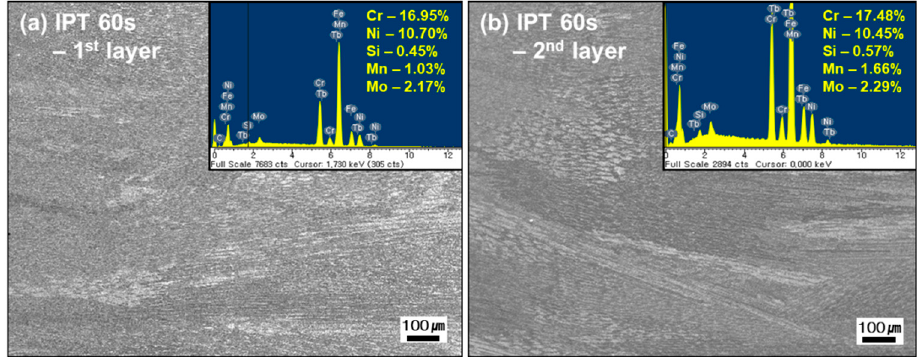
Figure 5. SEM micrographs and SEM-EDS analysis (inset) of 1 st ( a ) and 2 nd ( b ) layers.